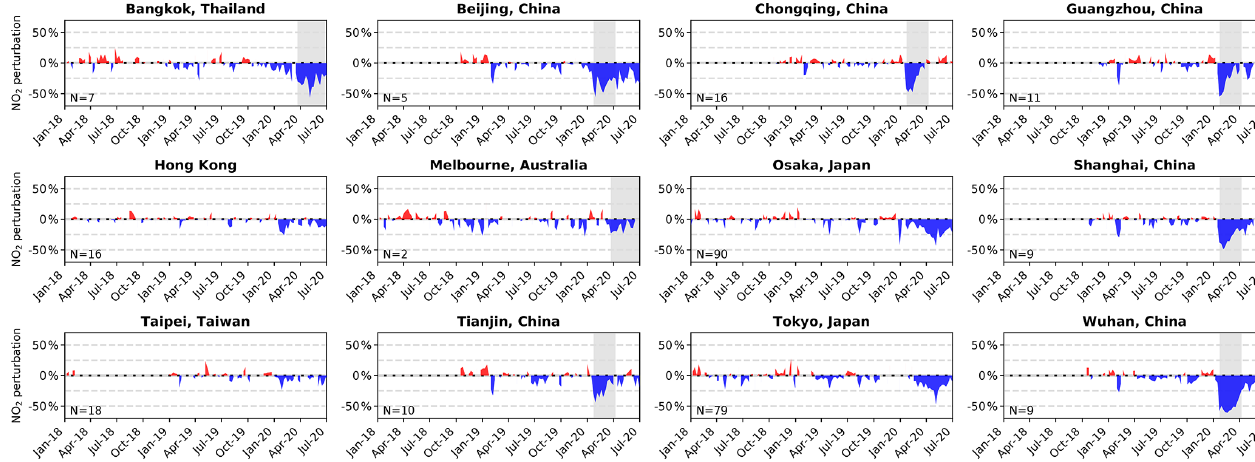
Figure A6. Normalized fractional NO 2 perturbations (observation–bias-corrected model, normalized by the bias-corrected model prediction) from 1 January 2018 through June 2020 for selected cities in Asia and Australia. Grey-shaded areas indicate COVID-19 lockdown periods. Number of sites per city are shown in the bottom left of each